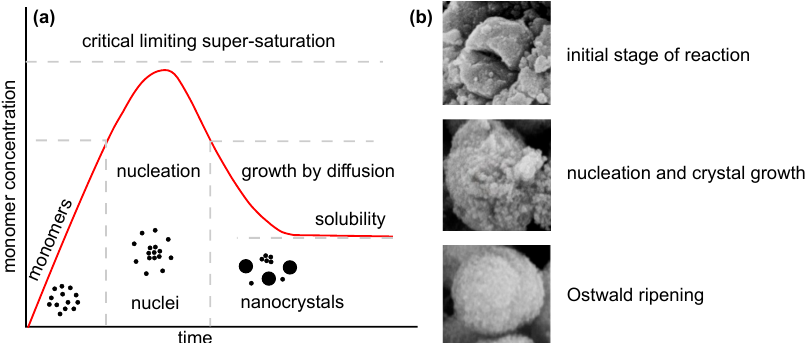
Figure 5. Illustration of nanoparticle growth: ( a ) LaMer model of nucleation and growth (redrawn and adapted from [64,65]) and ( b ) phases of growth (reprinted from article [66] distributed under the terms and conditions of the Creative Commons Attribution (CC BY)